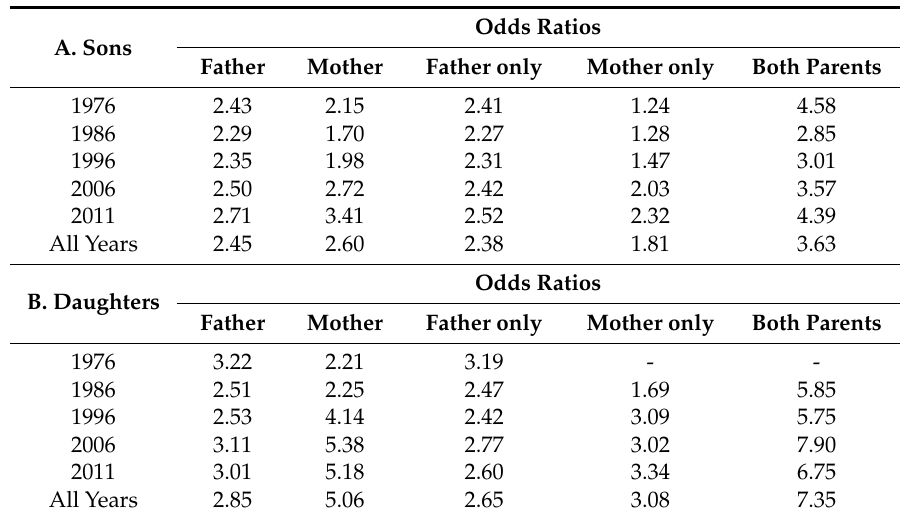
Table 2. Time Trends for Parent Child